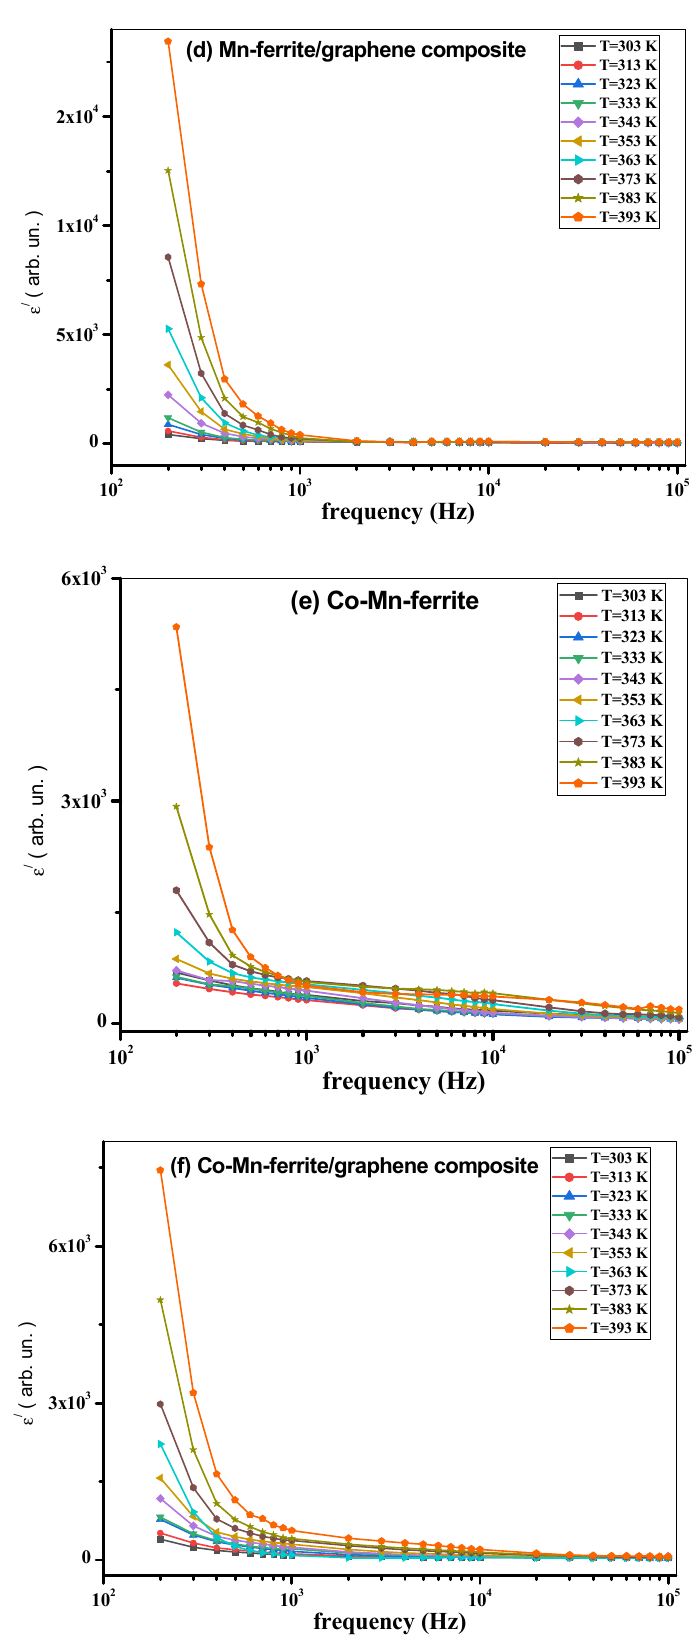
Figure 7. ( a ) ε ‘ vs. frequency at different temperatures of Co-ferrite, ( b ) Co-ferrite/graphene, ( c ) Mn- ferrite, ( d ) Mn-ferrite/graphene, ( e ) Co-Mn ferrite, and ( f ) Co-Mn ferrite/graphene samples.